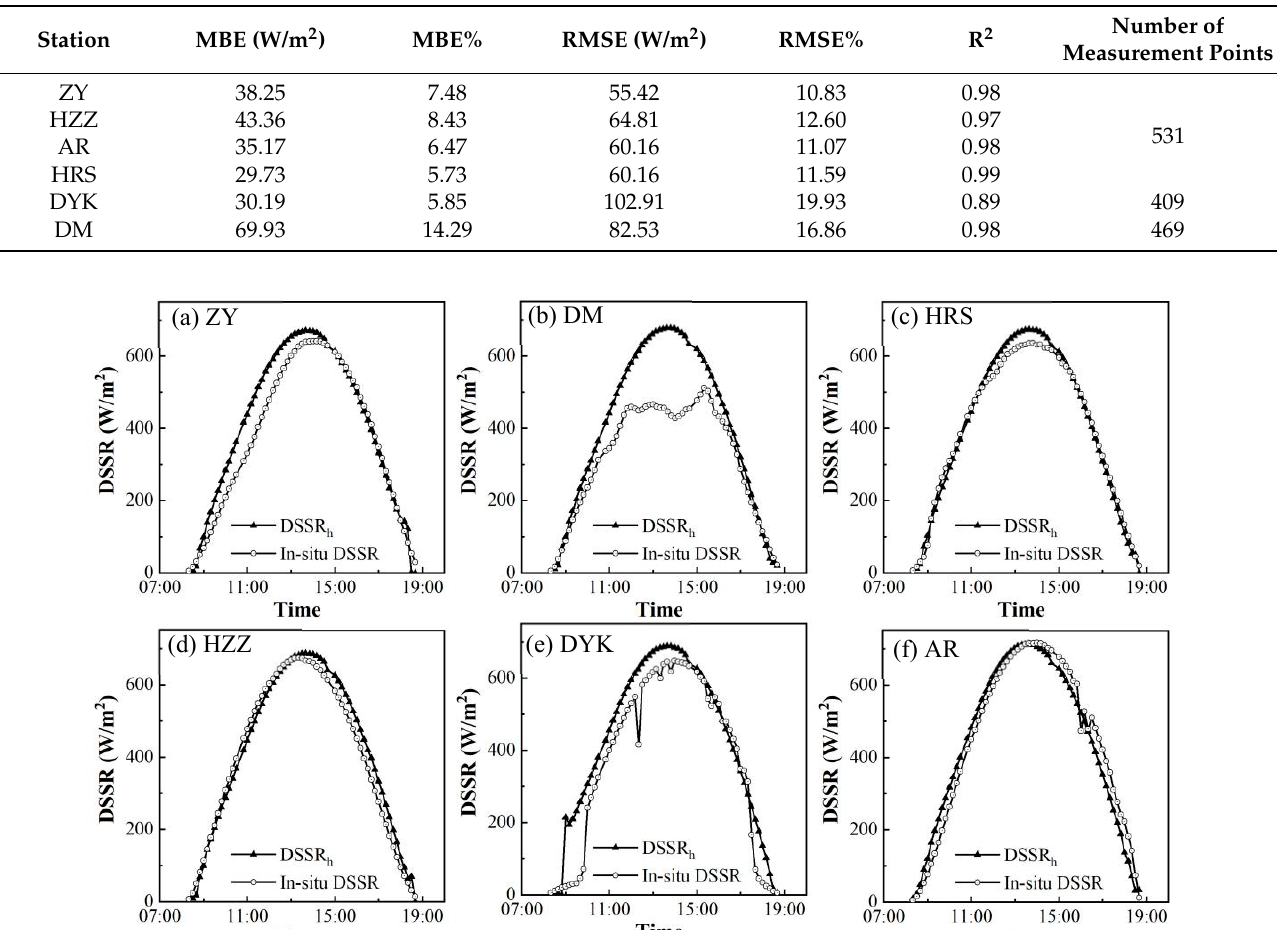
Table 5. Accuracy verification statistics of spatially downscaled DSSR in the middle and UM-HRB at different stations.